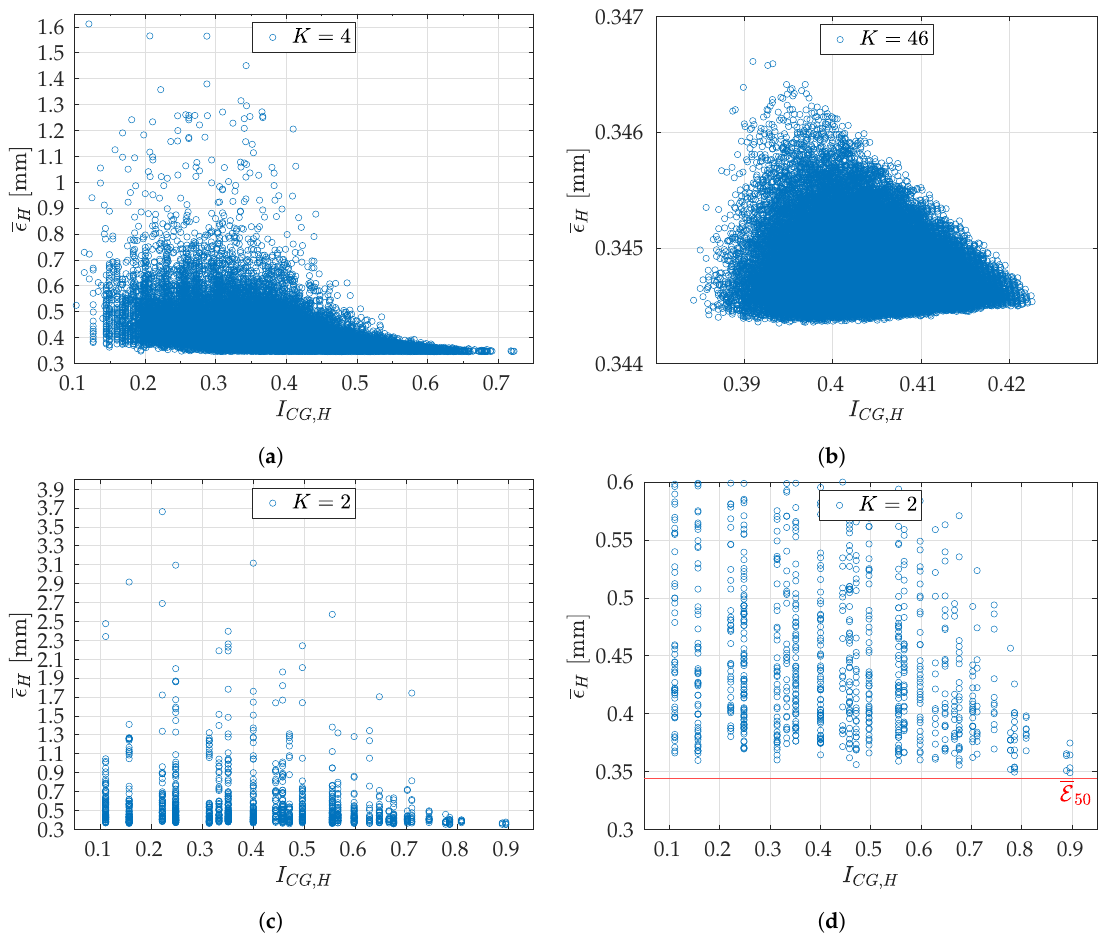
Figure 13. Relationship between (cid:101) H and I CG , H for N calibrations and for various K :( a ) K = 4 and N = 99,885; ( b ) K = 46 and N = 99,885; ( c ) K = 2 and N = b 2 = 1225; ( d ) same results as in ( c ), but zoomed-in at the error range [ 0.3,0.6 ] mm. Table 2. η H at different H and at various K